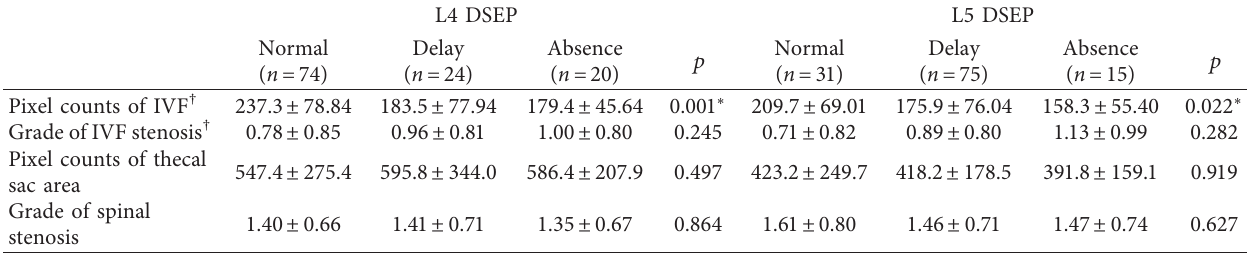
Table 4: Comparison of size (pixel counts) and stenosis grade of IVF and spinal canal according to DSEP